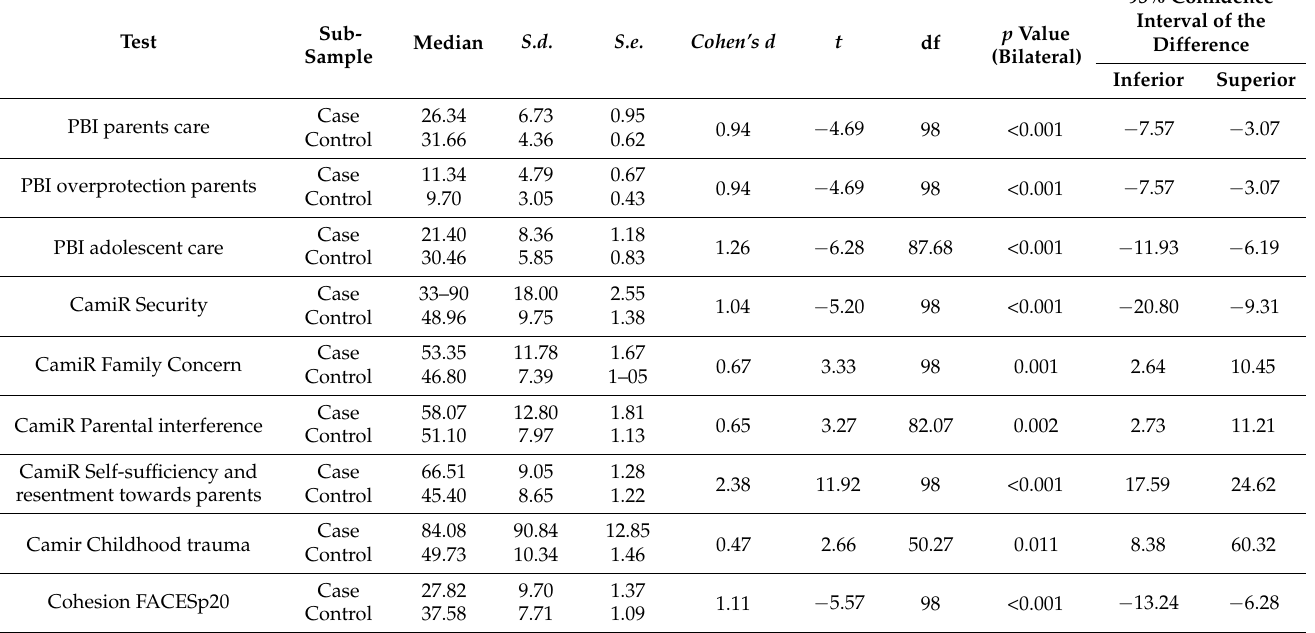
Table 2. Comparison of the family relationship variables (attachment, parental bonding, and family functioning) between cases and controls ( n cases = 50, n controls =